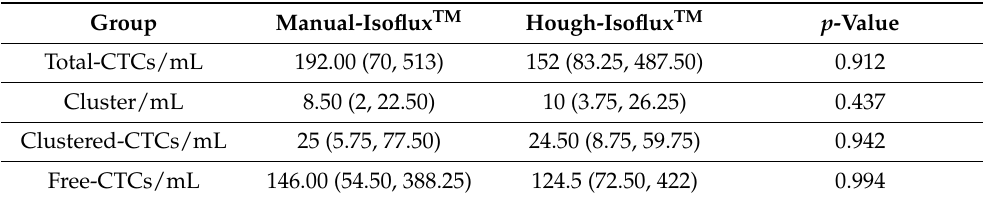
Table 3. CTCs were detected by the Manual-Isoflux TM System and by the Hough transform-Isoflux TM System algorithm in patients with pancreatic cancer.